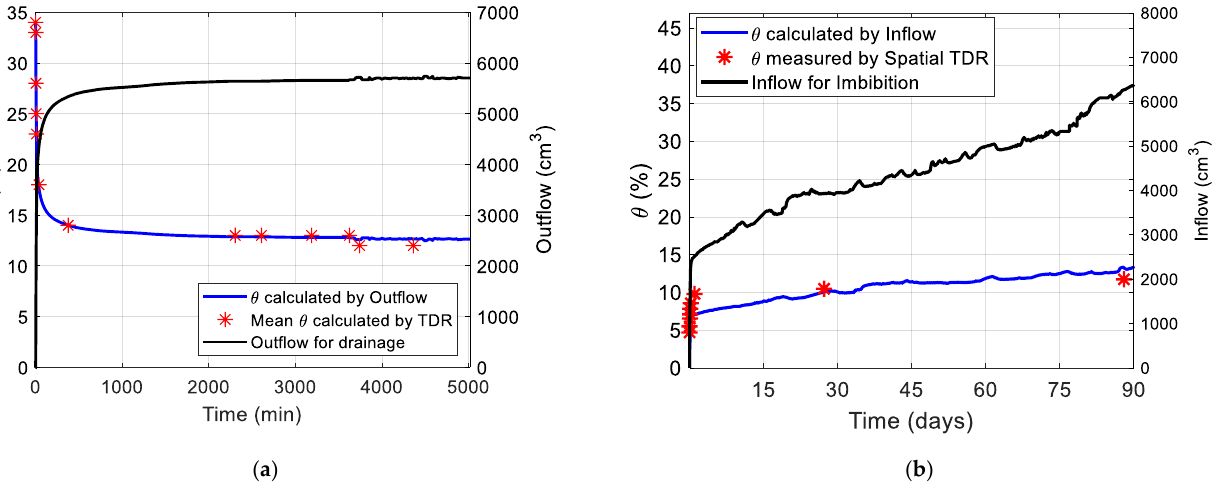
Figure 19. The validation between the average soil moisture contents measured by the conventional point-wise TDR technique and the average soil moisture contents calculated from accumulative outflow logging: ( a ) a demo of outflow; ( b ) a demo of inflow [49].